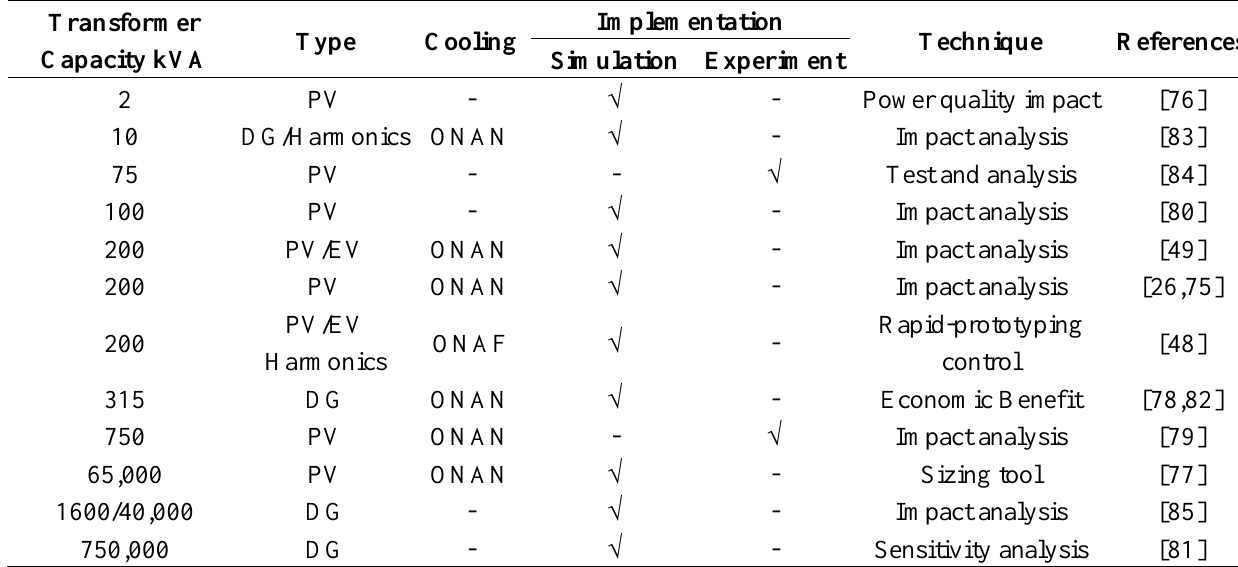
Table 4. Transformers on which the ageing is influenced by